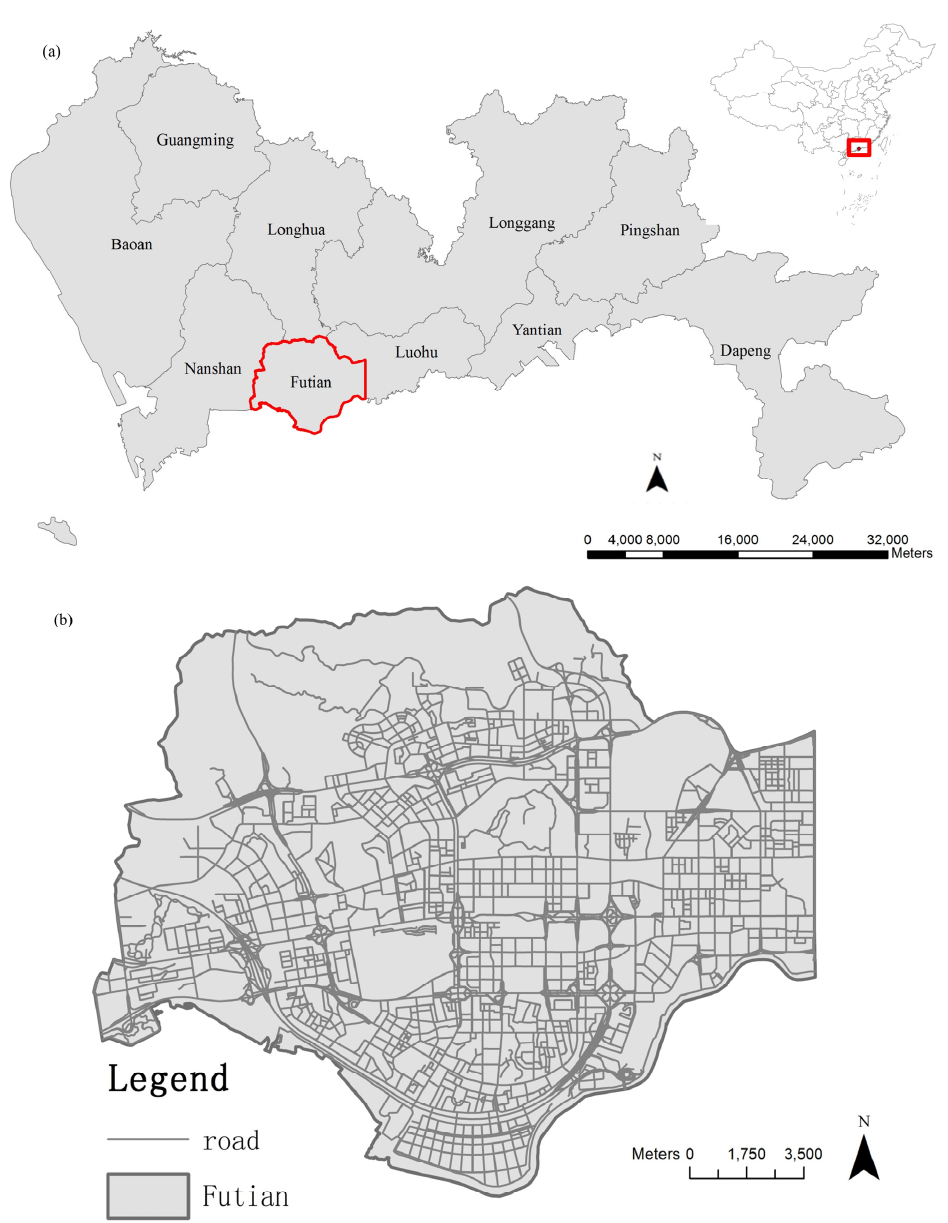
Figure 1. Shenzhen city and the study region: ( a ) the position of the study region (red box); ( b ) the road network in the study area.